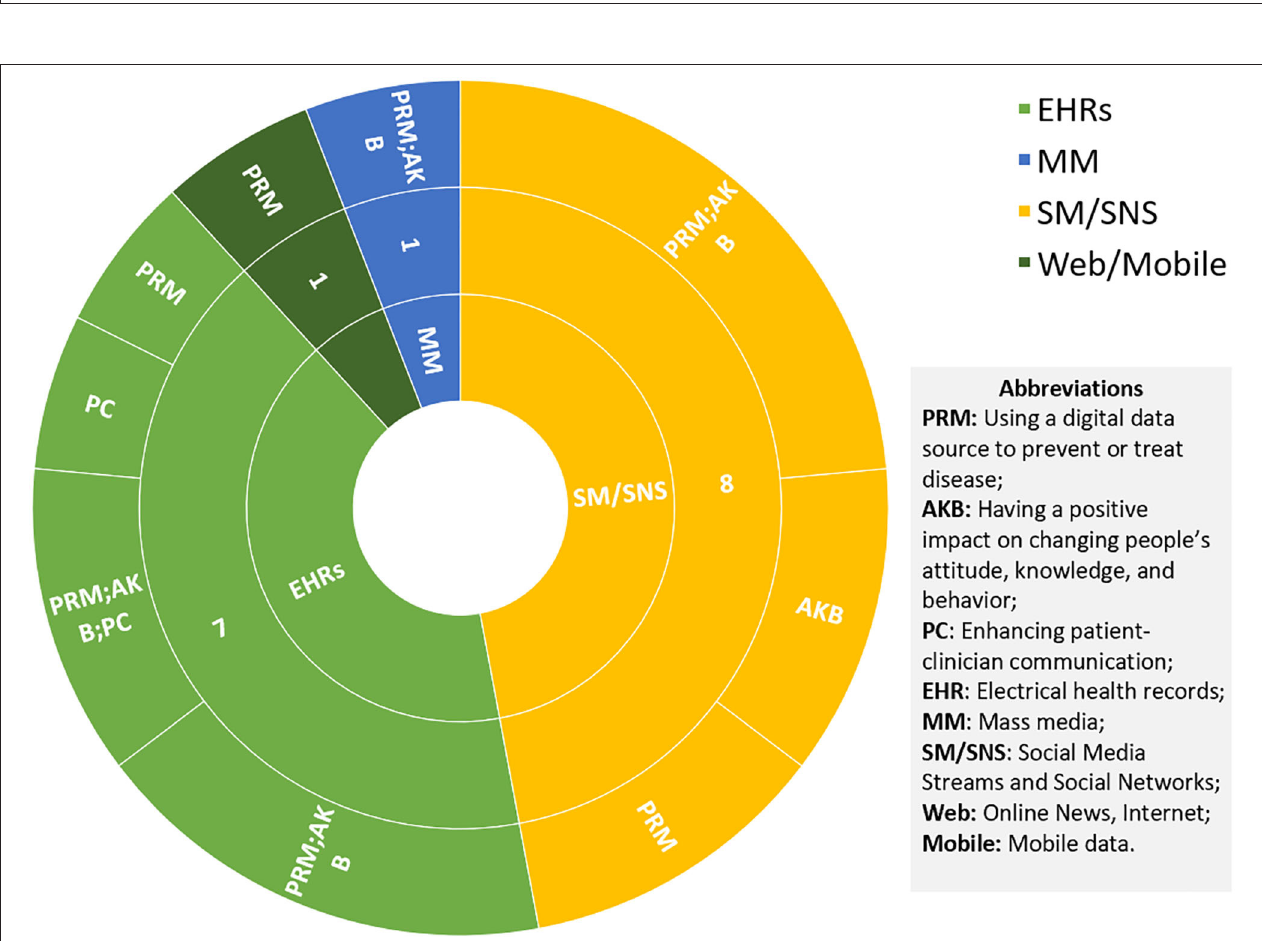
FIGURE 4 | Pie chart of the targeted group (left) and impact (right) of digital data sources on UHC.